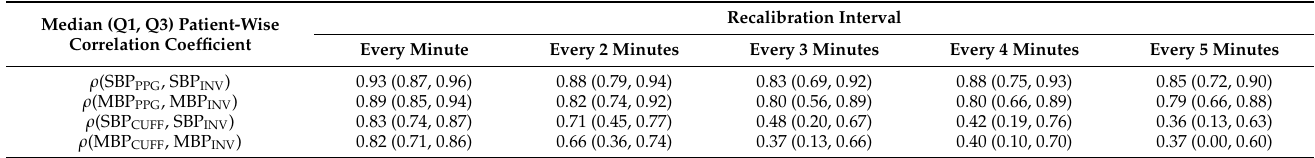
Table 3. Median (and first and third quartiles) of the per-patient Pearson’s correlation coefficient between each noninvasive BP estimate (BP PPG and BP CUFF ) and the invasive reference (BP INV ). Median (Q1, Q3) Patient-Wise Correlation